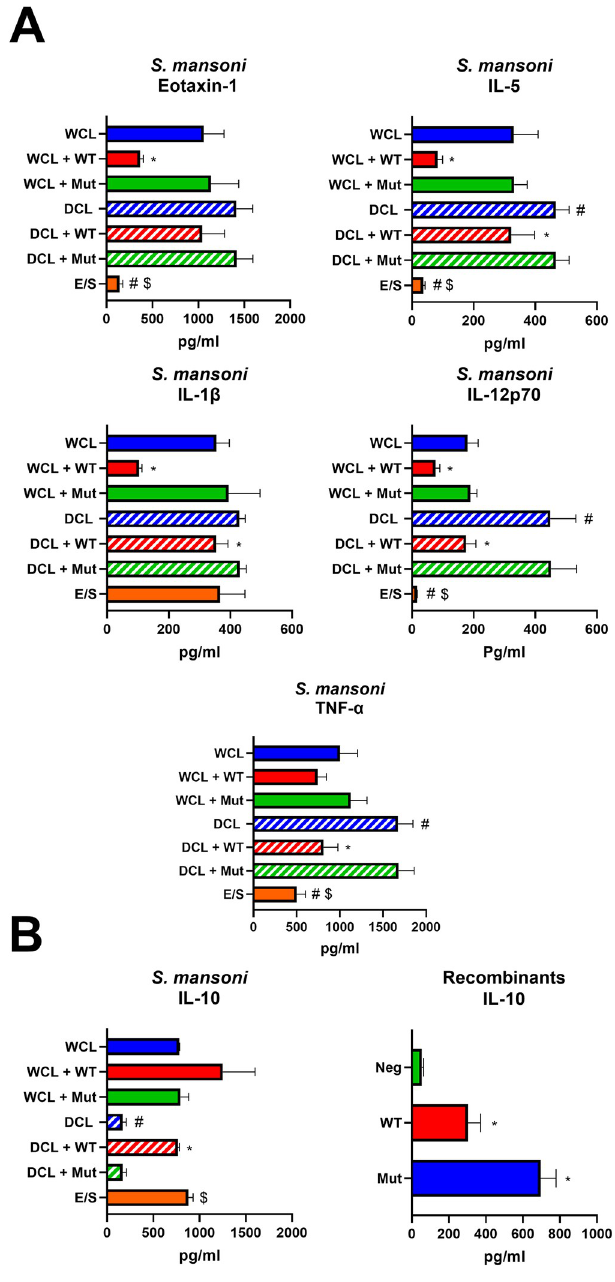
Fig 6. SmCI-1 alters cytokine profiles in an activity dependent manner when stimulated with whole cercarial lysate. Cytokine levels from human PBMCs as measured by Luminex panel presented in pg/ml. Differences in levels of key cytokines stimulated with whole cercarial lysate (WCL), drained cercarial lysate (DCL), or S . mansoni E/S products. Treatments with 2 μ g/ml of either wild type rSmCI-1 (WT) or mutant rSmCI-1 (Mut) effects levels of these cytokines. (A) Inflammatory cytokines and key chemokines for which effects are seen. (B) The effect of rSmCI-1 on the anti inflammatory cytokine IL-10 for both S . mansoni WCL and DCL-treated cells and cells exposed only to the recombinants. ( � ) Indicates significant differences between the treatment and either the relevant WCL/DCL control or (in the case of recombinant only treated cells) untreated negative control. (#) Indicates significant difference from WCL treated cells when comparing WCL, DCL and E/S only treated groups, while ($) indicates significant difference from DCL treated cells when comparing levels to E/S product stimulated cells. (n = 3).